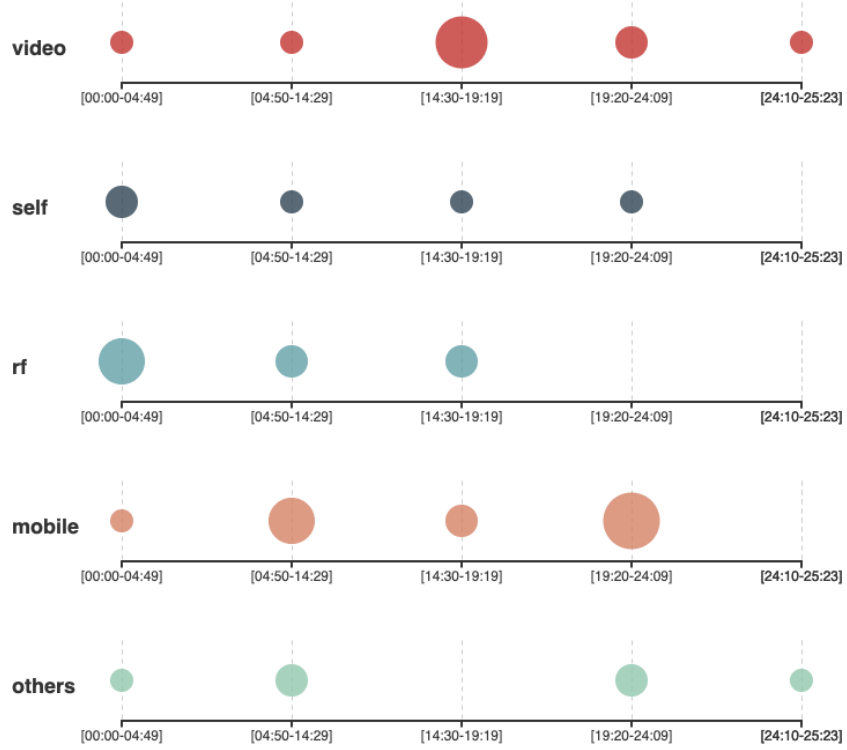
Figure 4. Frequency of mentions to different interaction mechanism by the PATH